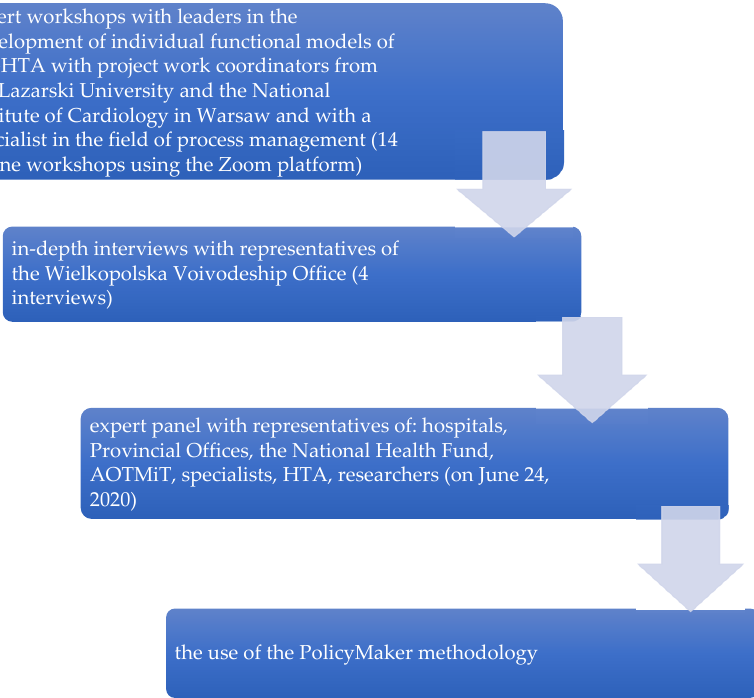
Figure 2. Methods used to create “mixed” model. PolicyMaker (PM), produced by Michael